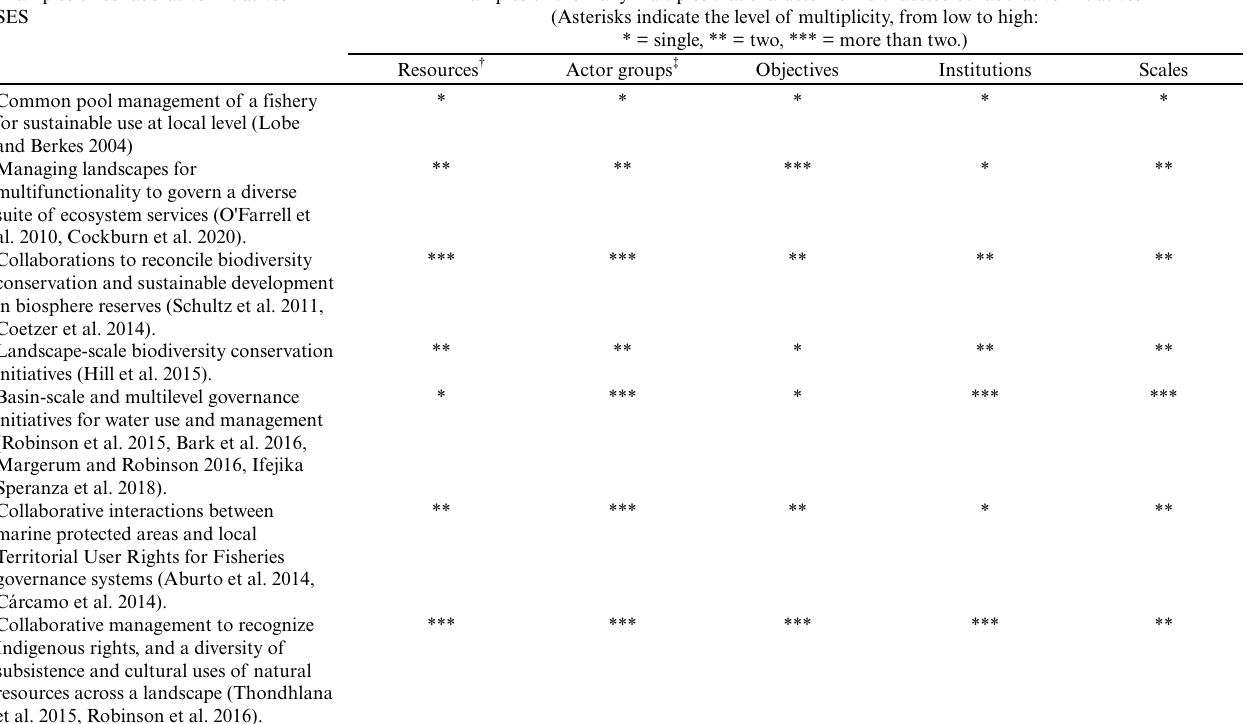
Table 1 . Illustrative examples of a diversity of multifaceted collaborative initiatives and the many multiples that characterize them in complex social-ecological systems